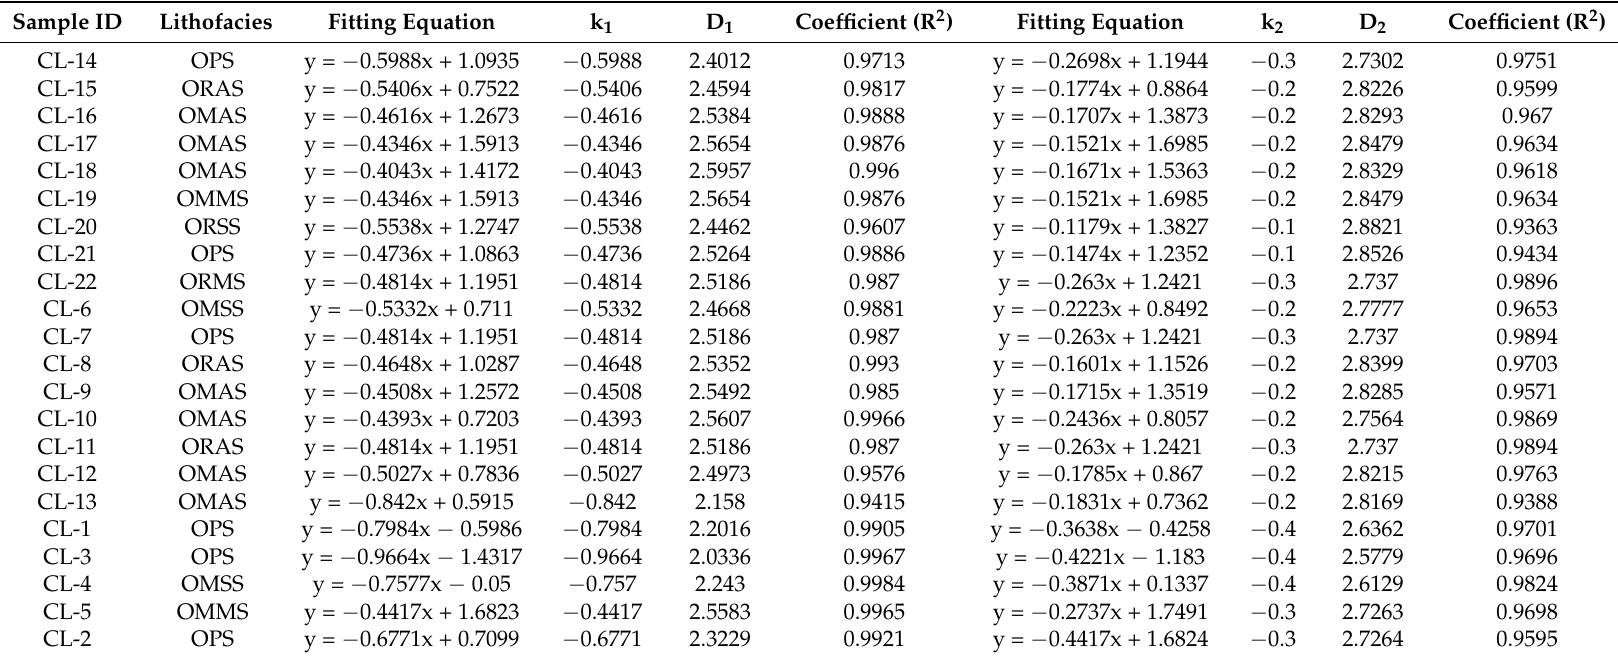
Table 3. Fractal dimensions obtained from the Frenkel–Halsey–Hill (FHH) model using LPNP